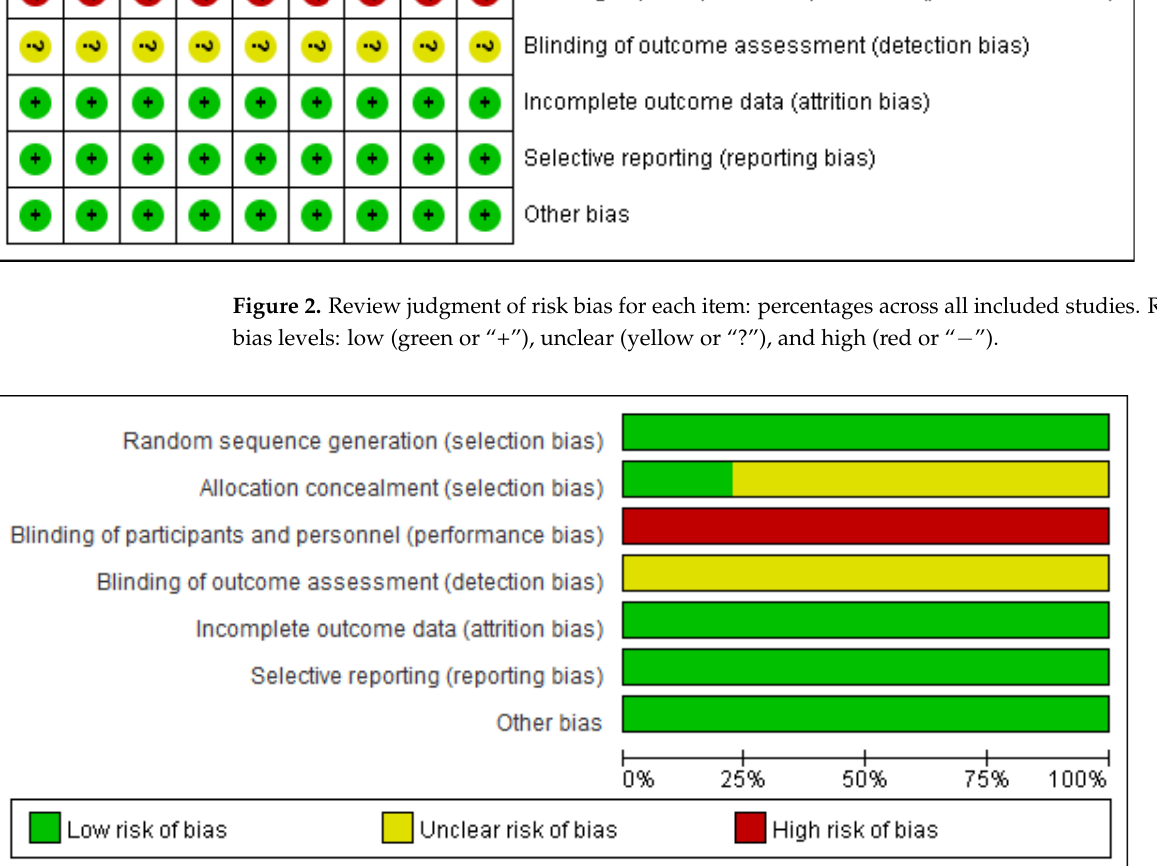
Figure 3. Summary of risk bias: review authors’ judgment of risk bias for each item. Risk of bias levels: low (green), unclear (yellow), and high (red).